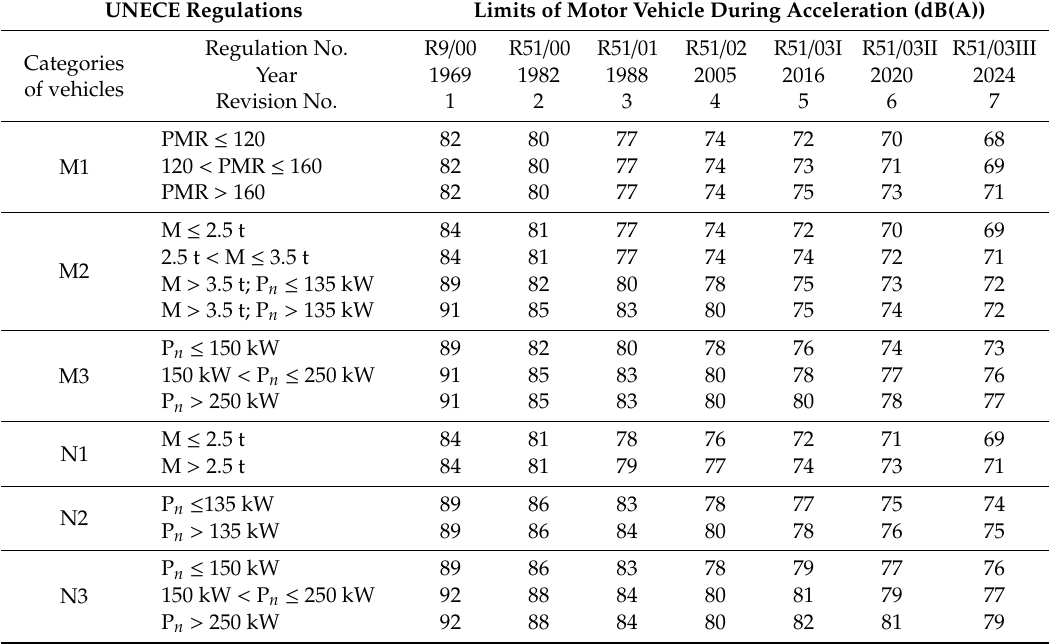
Table 1. Limits of motor vehicle noises during acceleration regarding noise emissions in United Nations Economic Commission for Europe (UNECE)